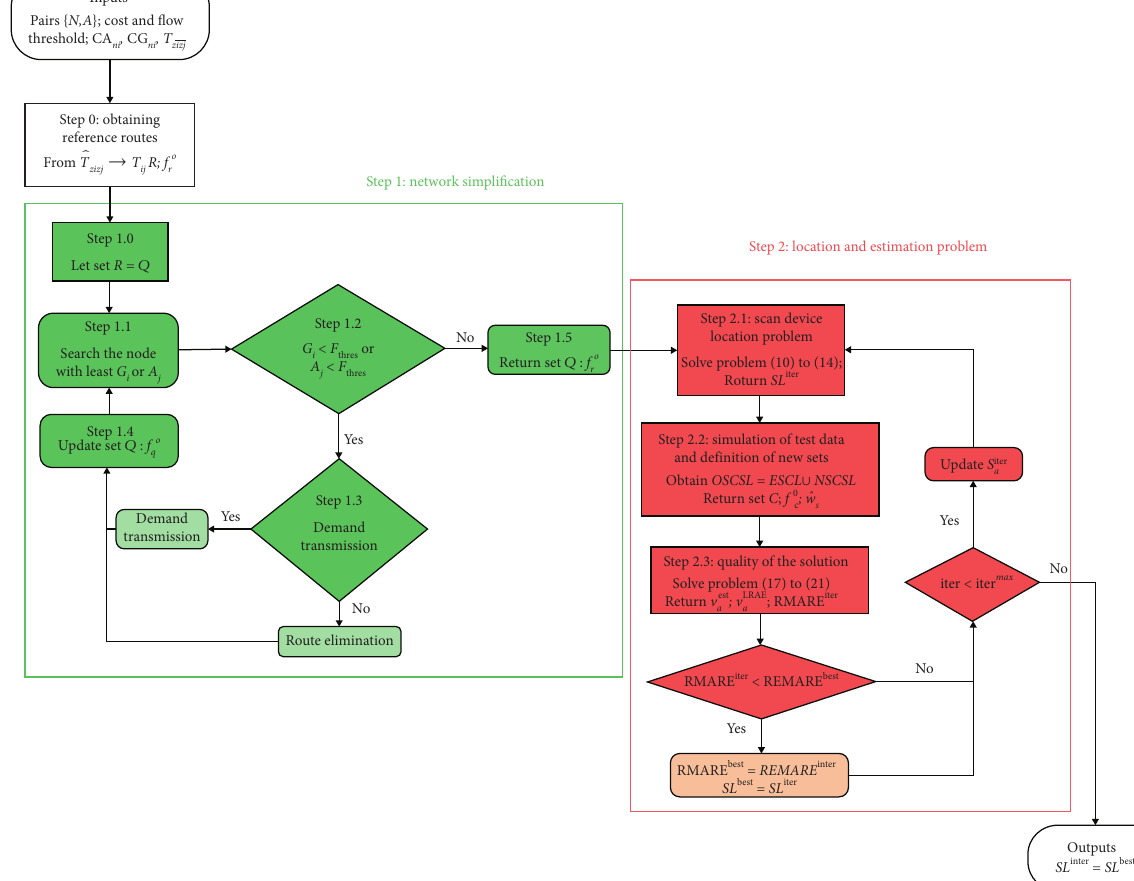
Figure 6: Flowchart of the